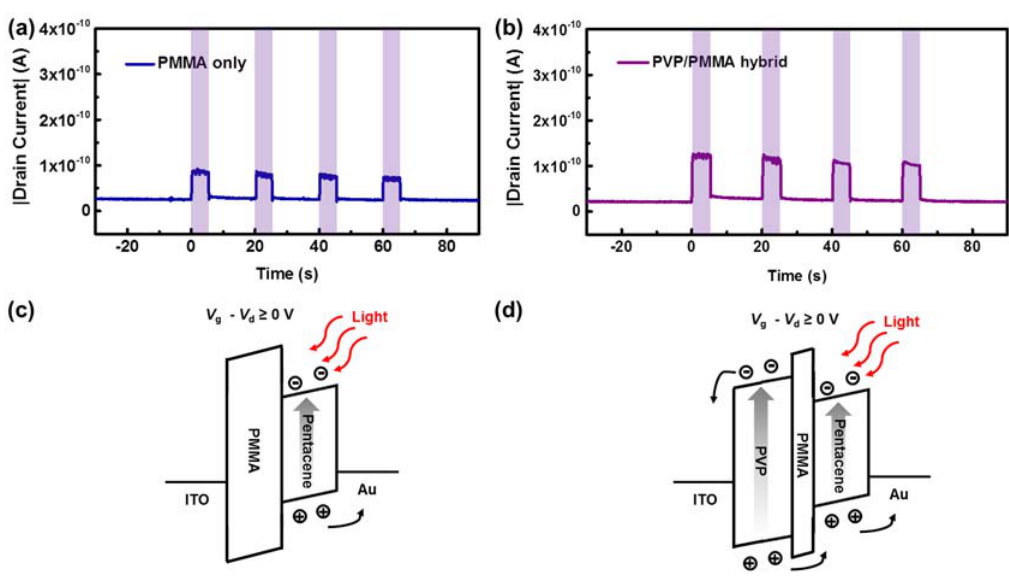
Figure 4. Dynamic photoresponsive behavior of the OPTs with the ( a ) single-polymer PMMA gate insulator and ( b ) hybrid PVP/PMMA gate insulator. The shaded areas indicate the state of the device when exposed to UV light. Schematic diagrams illustrating the operating principles of the OPTs with the ( c ) single-polymer PMMA gate insulator and ( d ) hybrid PVP / PMMA gate insulator.